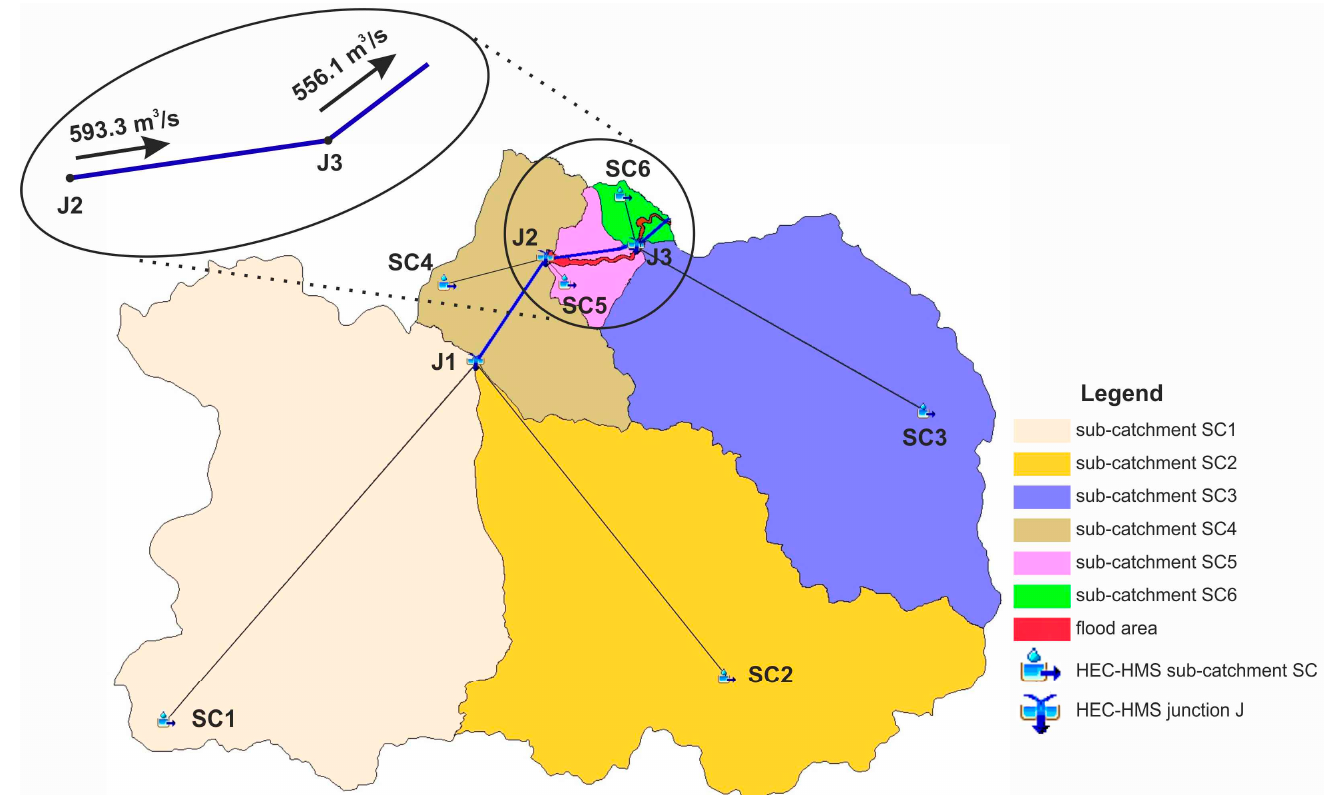
Figure 8. HEC-HMS hydrological model of the studied (hydro) area, featuring its six sub-catch- ments and three junctions, with detail of the calculated design discharges used in